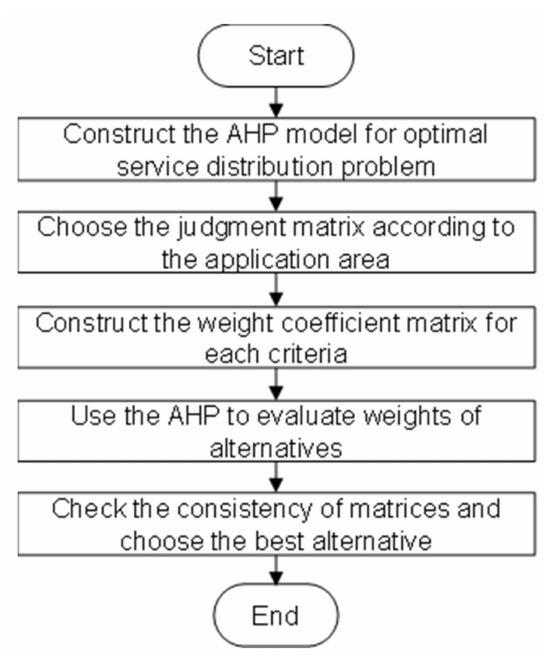
Figure 6. Hierarchical framework for AHP.